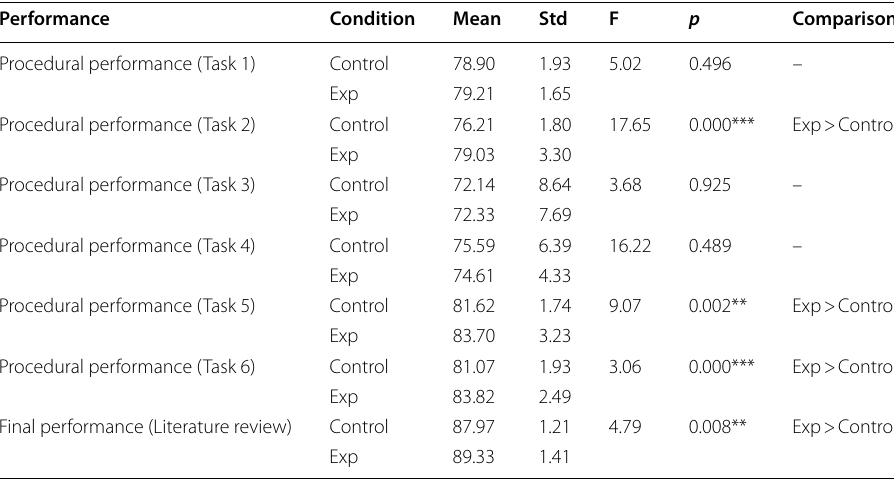
Table 6 The t-test comparison of group performances between two